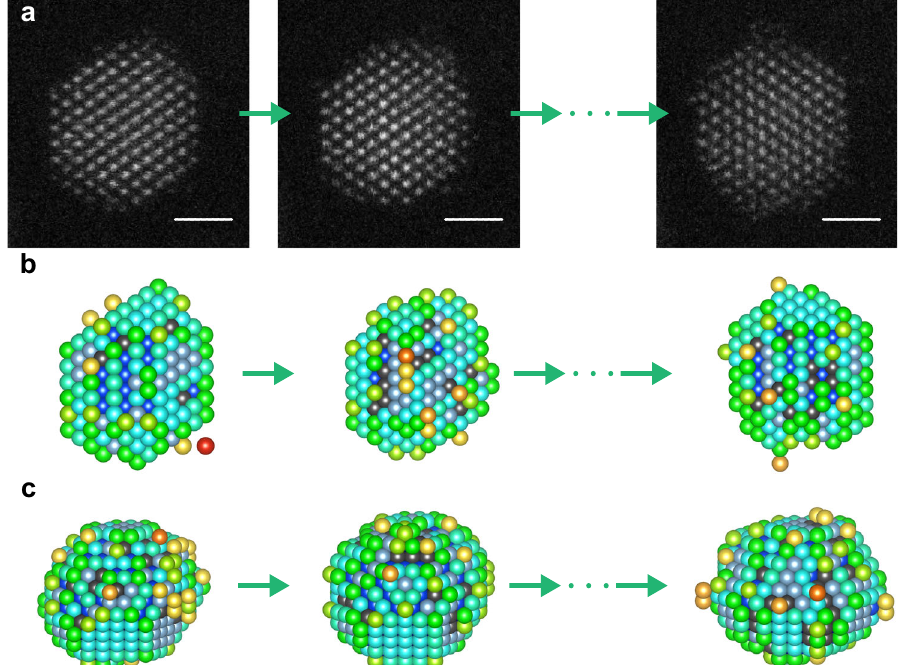
Fig. 5 Analysis of an experimental time series of a catalyst Pt nanoparticle. a ADF STEM time series. b Corresponding reconstructed 3D atomic models for the time sequence viewed along the beam direction. c Rotated models to show the dominant surface facets. The coloring of the atoms corresponds to the nearest-neighbor coordination, from 1 in red to 12 in dark blue. The scale bars in a are 10 Å